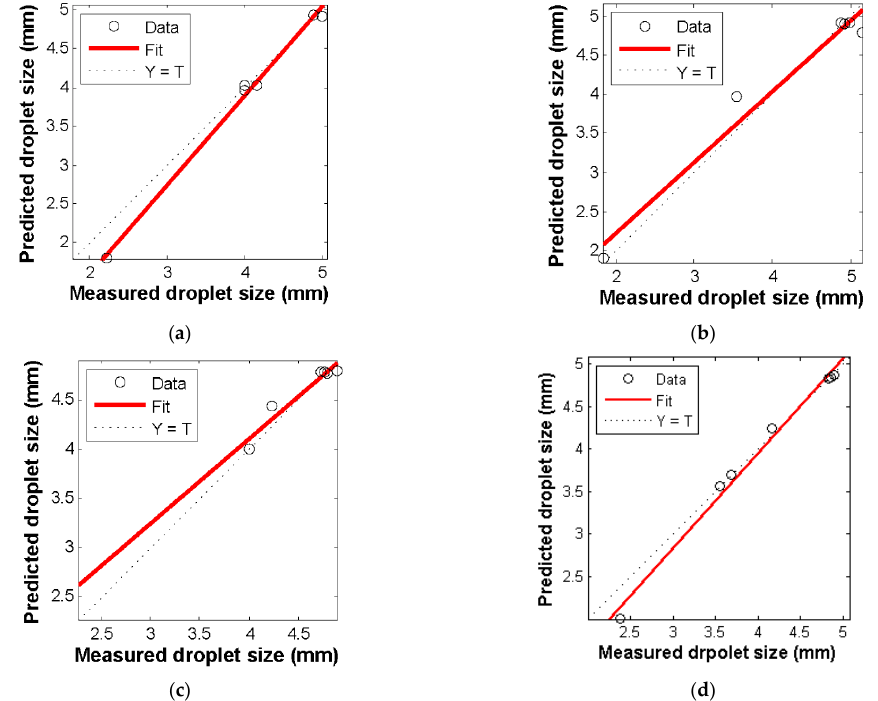
Figure 4. Comparison of the measured versus predicted droplet sizes for different pressures ( a ) 150, ( b ) 200, ( c ) 250 and ( d ) 300 kPa. Table 3. Indices of the different sprinkler base pressures in predicting droplet diameter . Parameter